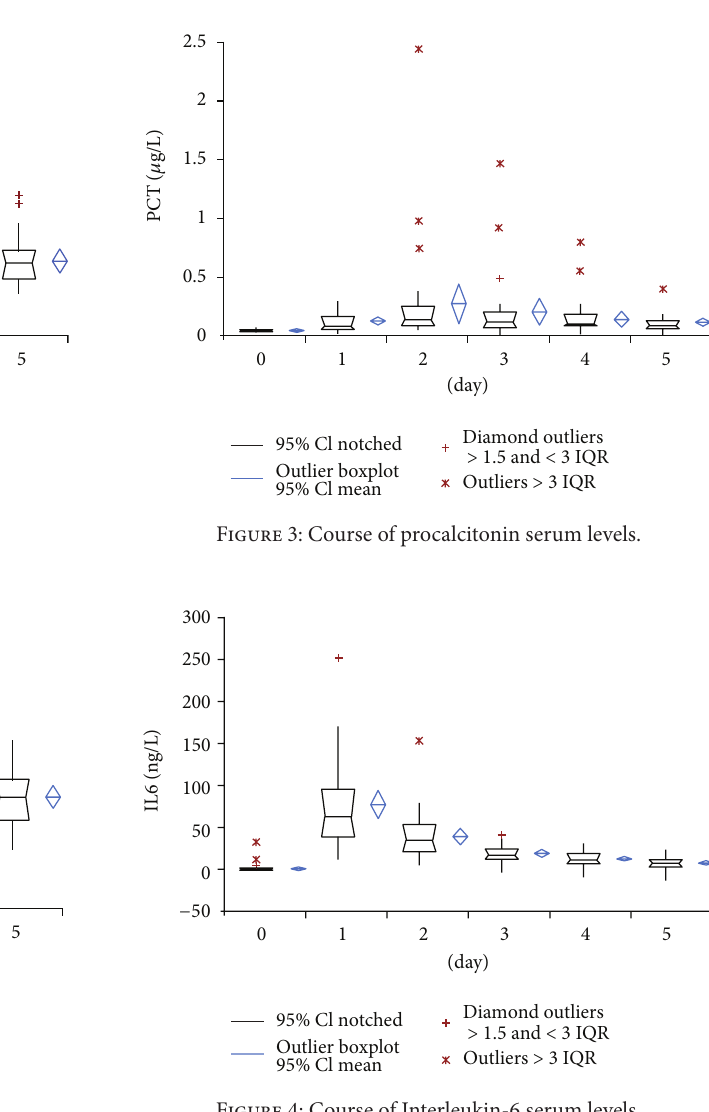
Figure 4: Course of Interleukin-6 serum